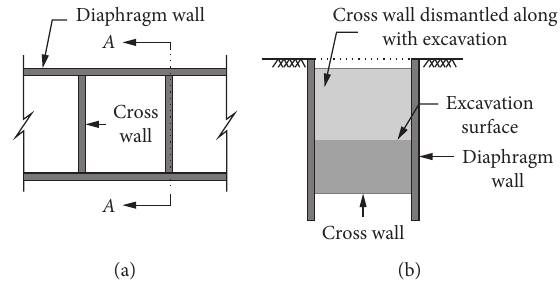
Figure 1: Schematic diagram of the cross wall: (a) plan view; (b) section